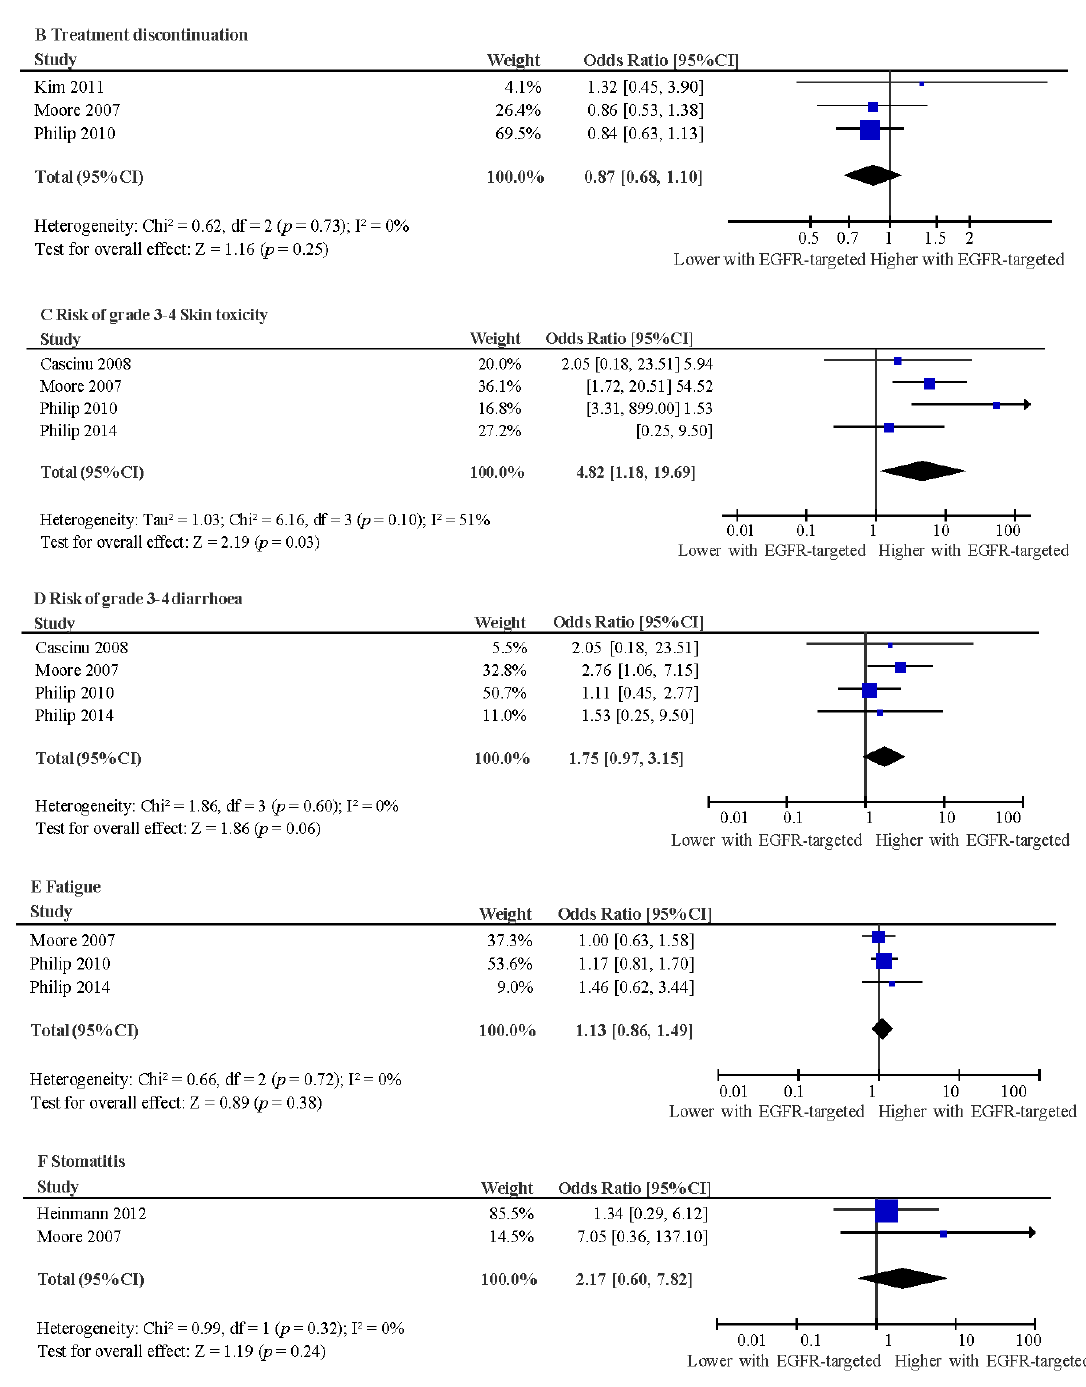
Figure 5. Forest plots showing odds ratio for toxic death ( A ), treatment discontinuation ( B ), risk of grade 3–4 skin toxicity ( C ), risk of grade 3–4 diarrhoea ( D ), fatigue ( E ) and stomatitis ( F ) for addition of EGFR-targeted treatment to chemotherapy versus control. Experimental arm: EGFR-targeted therapy + chemotherapy; Control: chemotherapy; CI: confidence interval.